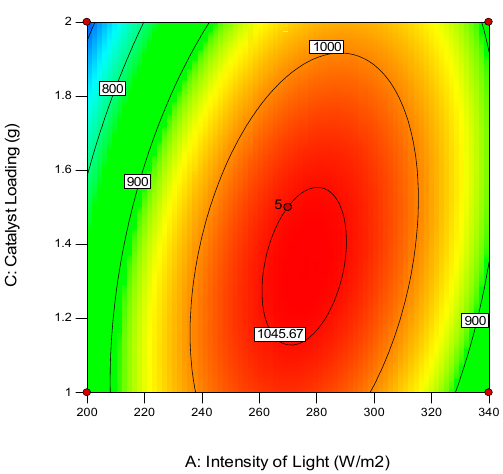
Figure 12 . Effect of the intensity of light and catalyst loading on methanol yield .